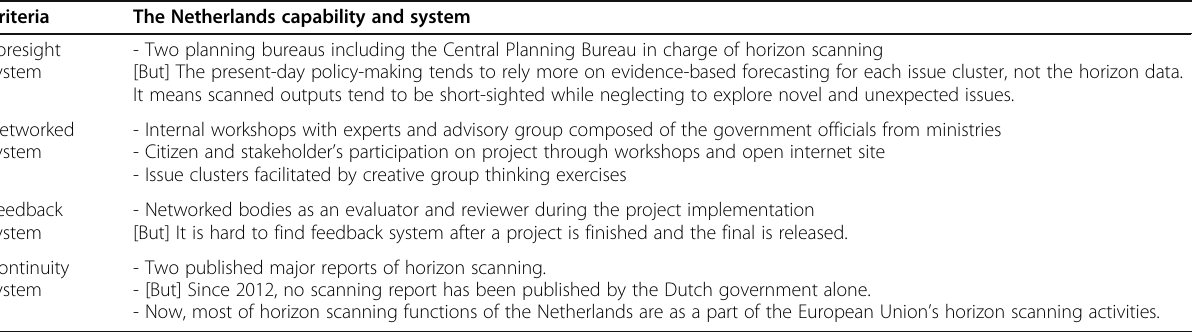
Table 5 The Netherlands ’ s AG level under the new framework